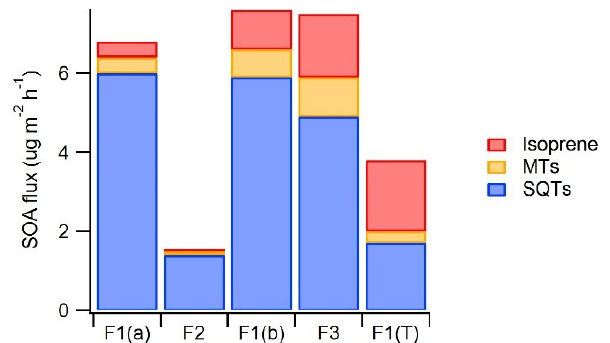
Table 3. Ambient air concentrations of sesquiterpenes (SQTs), monoterpenes (MTs) and isoprene during the ambient air